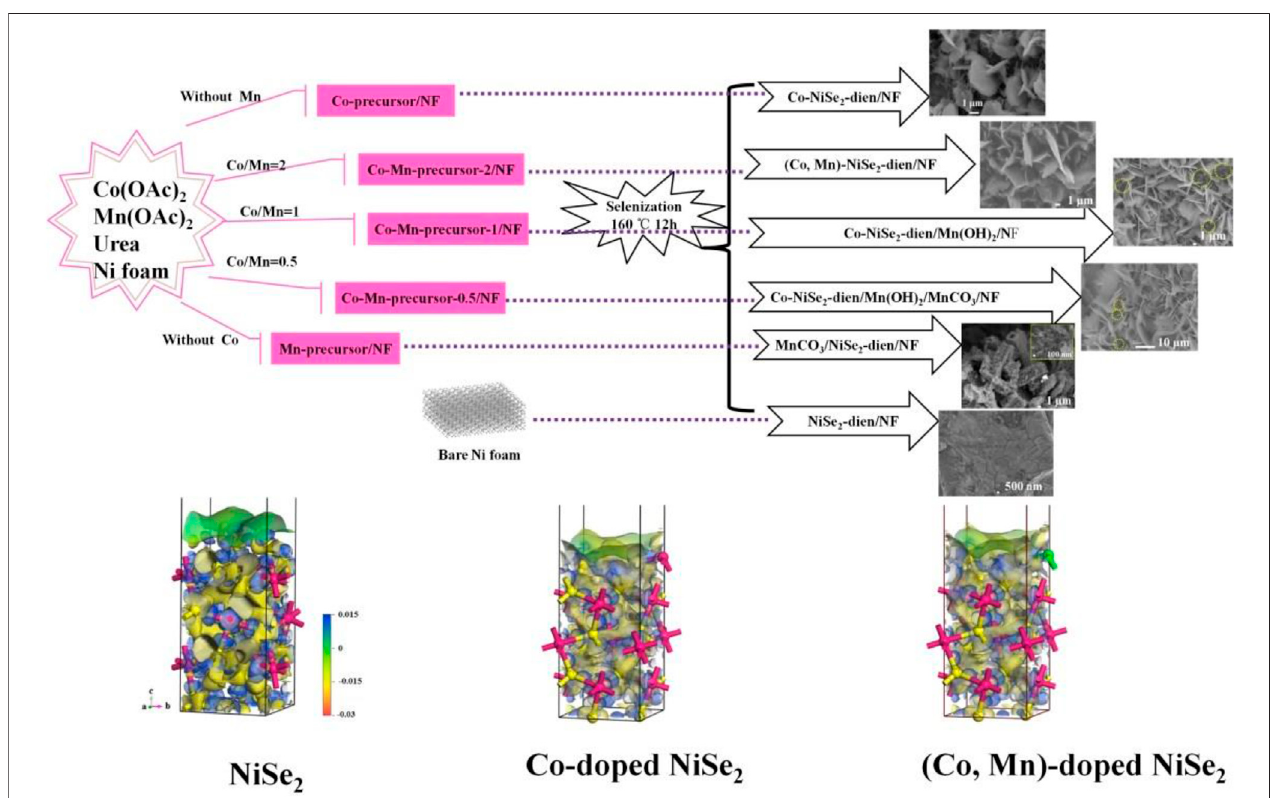
FIGURE 23 | (Co, Mn)-doped NiSe 2 -diethylenetriamine (dien) nanosheets and (Co, Mn, Sn)-doped NiSe2 nanowires for high performance supercapacitor.